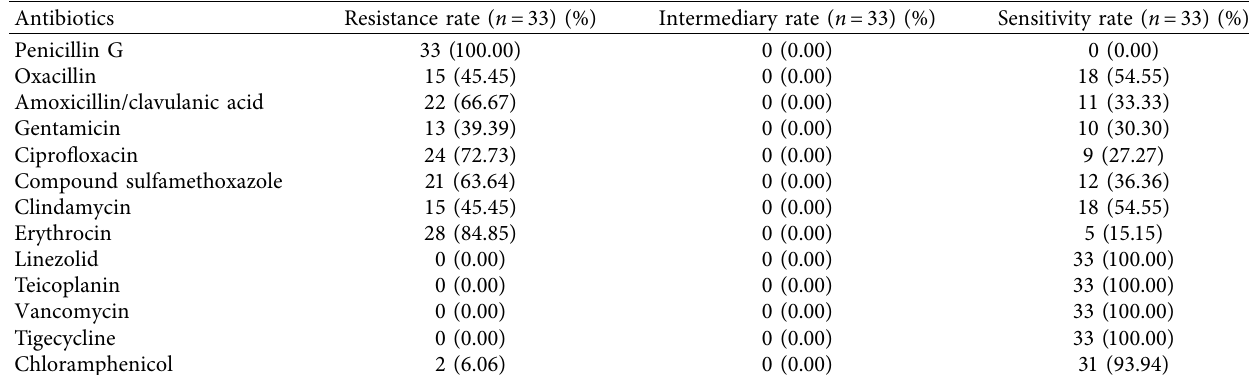
Table 2: Antimicrobial resistance rate of the 33 Staphylococcus aureus strains.